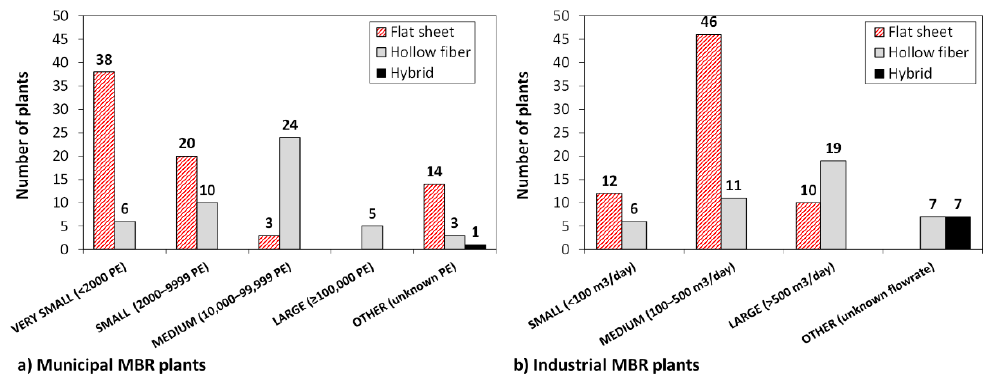
Figure 3. Italian MBR plants split by type of membrane used.